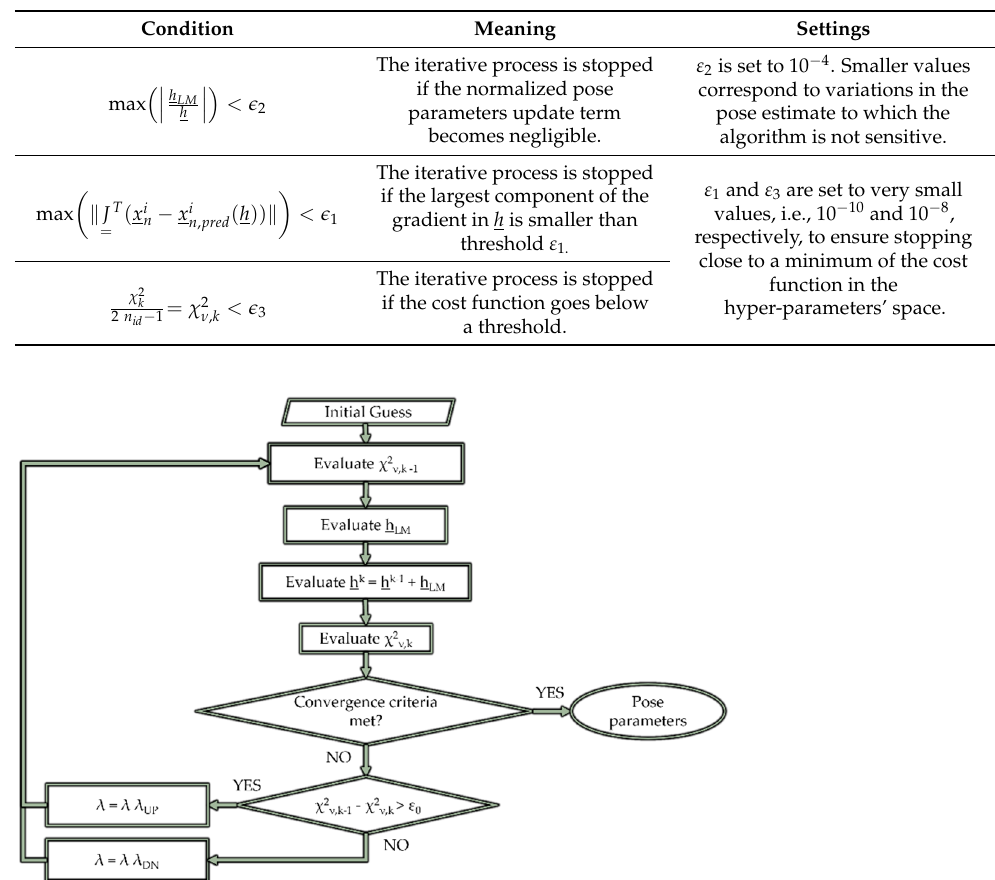
Table 2. Convergence conditions for the proposed implementation of the LM technique for pose determination.